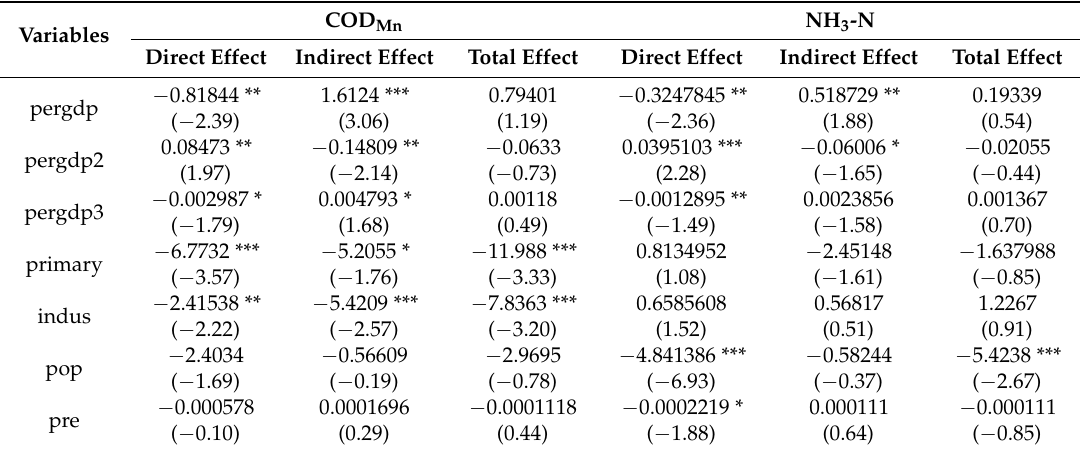
Table 6. Direct and indirect effects of each explanatory variable.